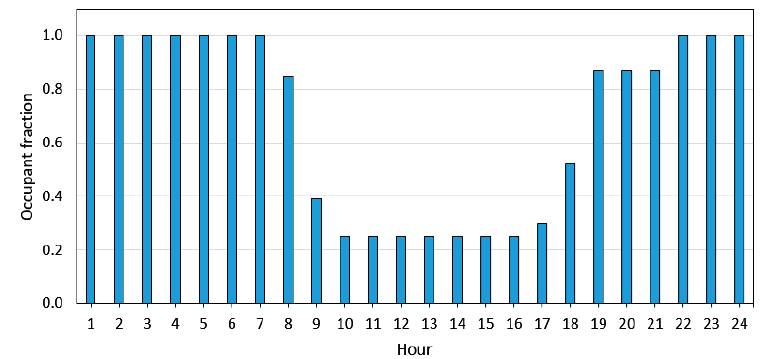
Figure 9. Internal heat load schedule.